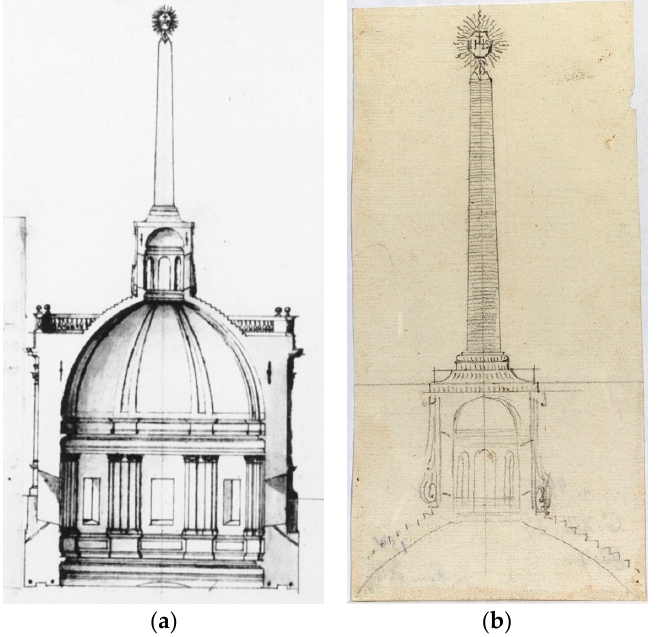
Figure 4. ( a ) Orazio Grassi, ca.1650, Project for the dome of St Ignatius. (BAV—Vat.lat. 11257.pt.a fol 117 r). Copyrights and Credits: BAV Biblioteca Apostolica Vaticana, 2022 and ( b ) Orazio Grassi, ca.